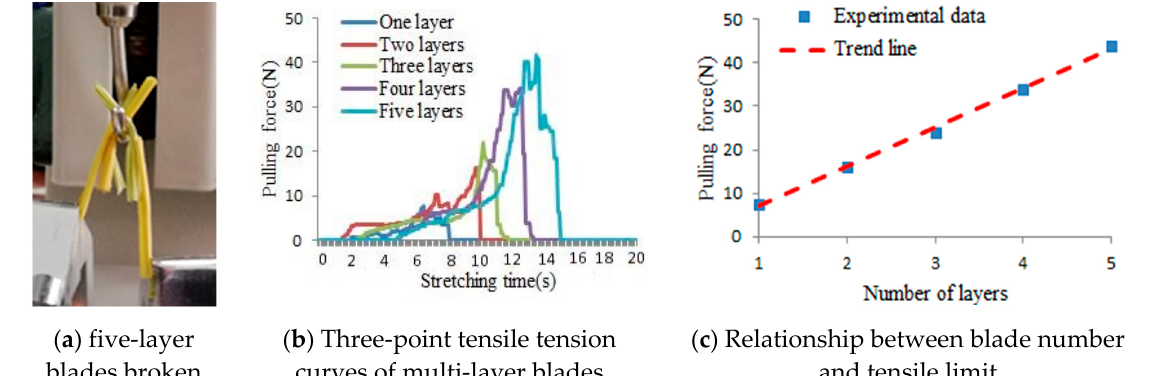
Figure 17. Tensile properties of multiple blades at normal temperature.